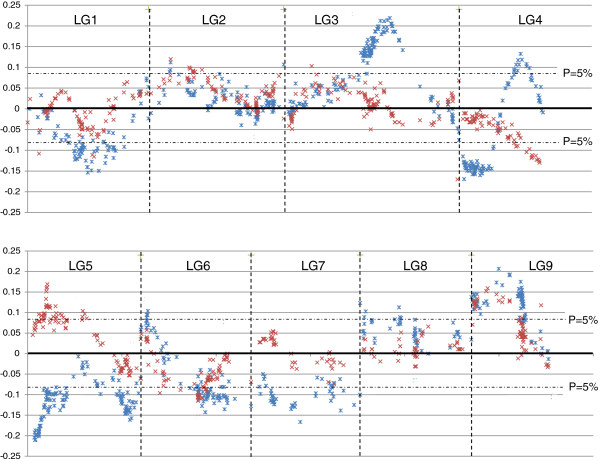
Distribution of the segregation distortions for female and male Clementine, along the reference Clementine genetic map. The x axis represents the location on each linkage group (LG) and y axis represents the excess of the mandarin allele relatively to Mendelian segregation (y = frequency of mandarin allele minus 0.5). Blue represents male Clementine segregation; red represents female Clementine segregation. The discontinuous lines represent the threshold for significant distortion (p < 0.05).